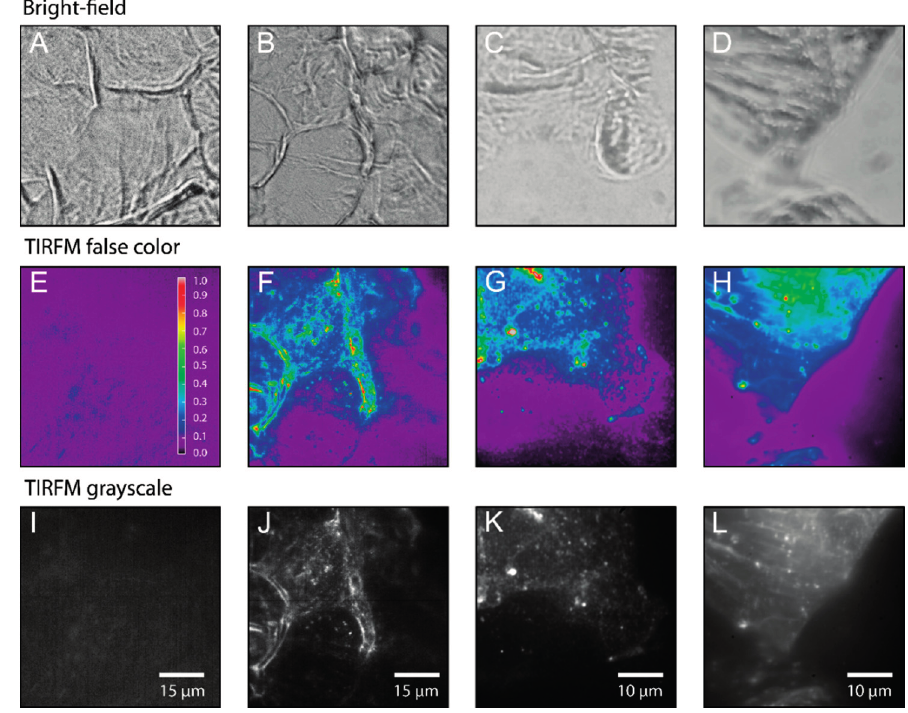
Figure 4. Bright-field microscopy ( A – D ), false color coded images representing the relative fluorescence intensity ( E – H ) and grayscale TIRFM images ( I – L ). ( A , E , I ) Control sample (unstained) from tape 5. ( B – D , F – H , J – L ) Three different ATTO-OXA12